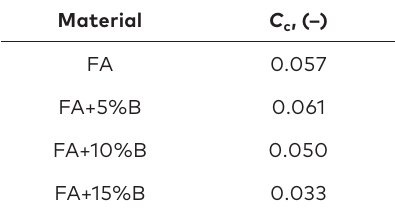
Table 3. The compression index values of tested